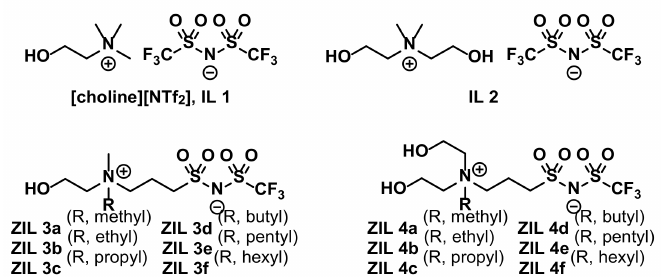
Figure 1. Structures of [NTf 2 ]-based ionic liquids ( IL 1 and IL 2 ) and NTf-based zwitter-ionic liquids ( ZIL 3a – f and ZIL 4a – f